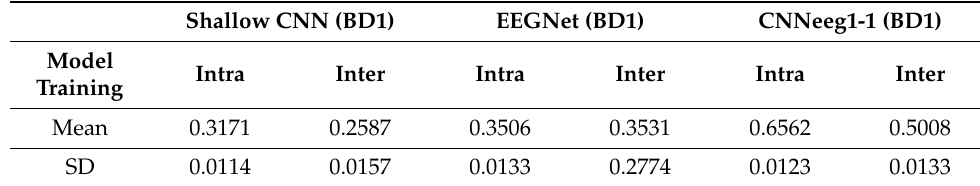
Table 4. Average accuracy of the reference algorithms Shallow CNN, EEGNet, and the new algorithm CNNeeg1-1 for the classification of imagined vowel tasks for intra-subject and inter-subject training using BD1 database. Shallow CNN (BD1)